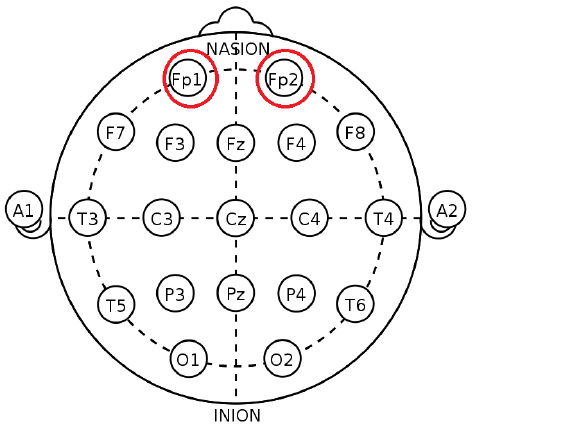
Figure 1. The attached sensors in the 10–20 system